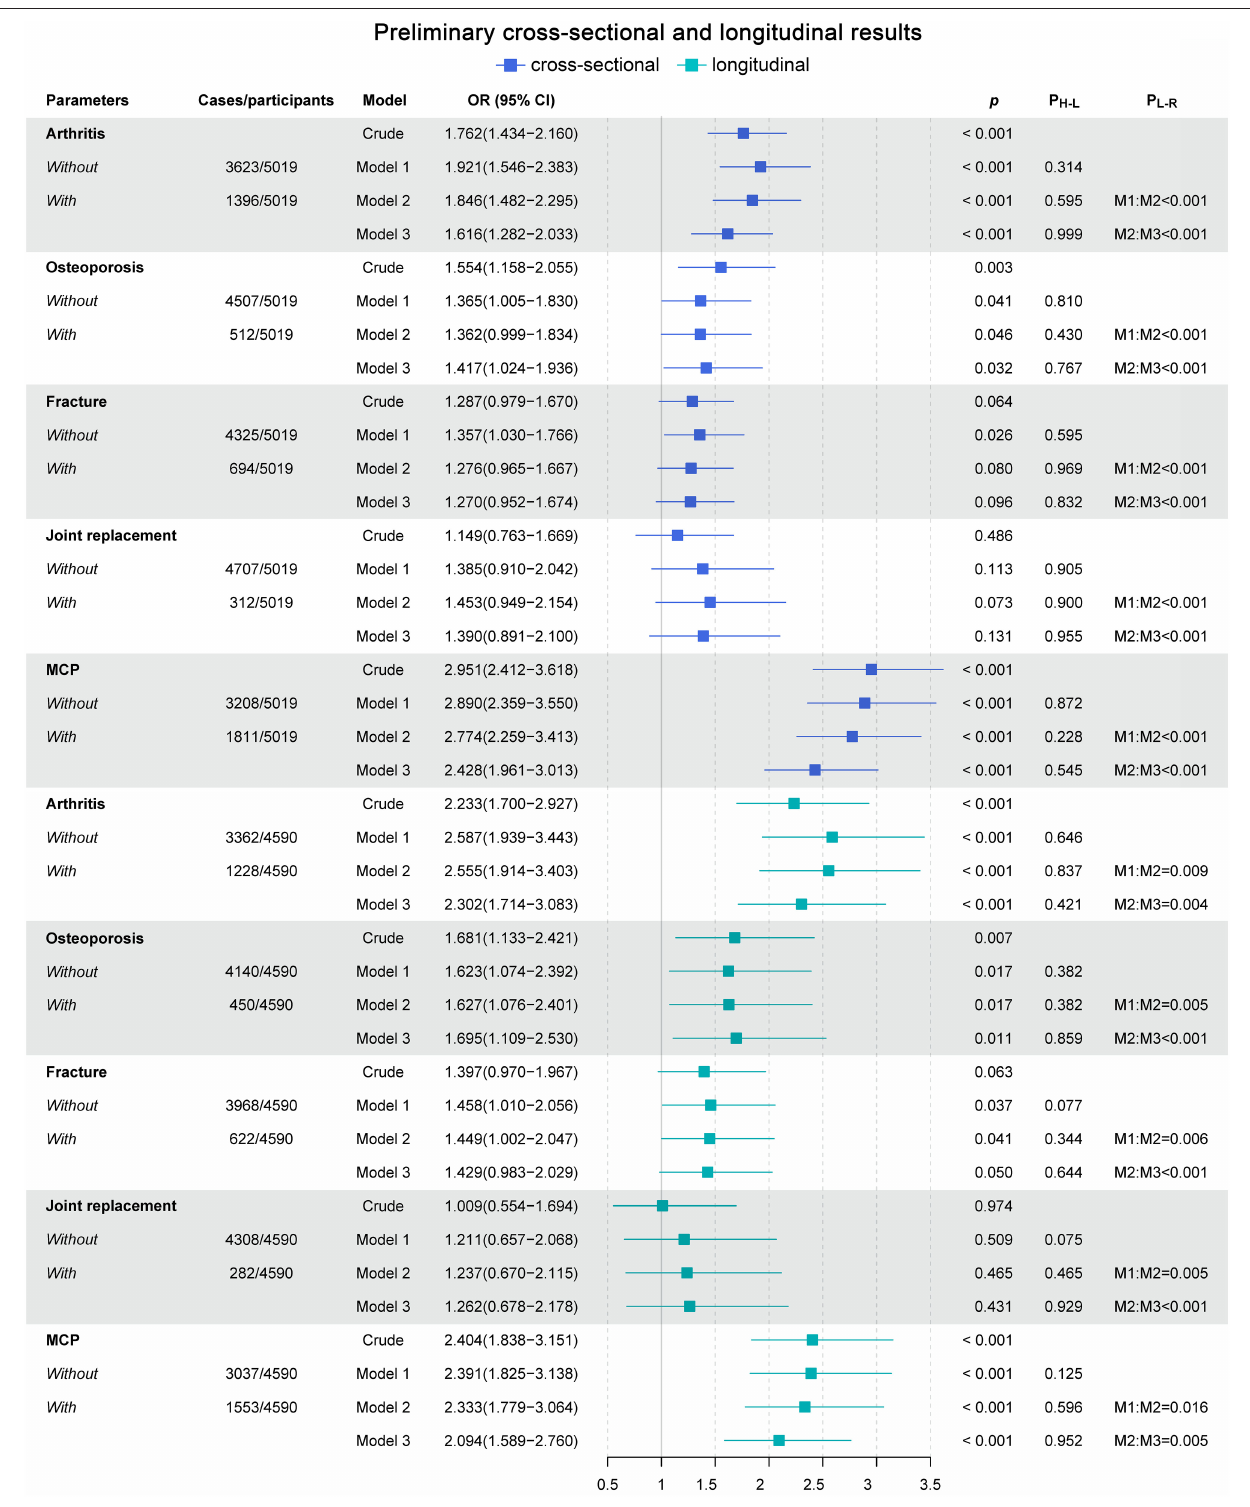
FIGURE 1 | Preliminary cross-sectional and longitudinal results. Model 1 adjusted for gender and age. Model 2 adjusted for Model 1 and place of residence, smoking status, and marital status. Model 3 adjusted for Model 2 and an abnormal heart rhythm, congestive heart failure, angina, myocardial infarction, BMI, diabetes, TRIG, LDL, HDL, CHOL, cognitive score, use of medication [i.e., benzodiazepines, antihypertensives (ATC C09, C08, C07, C03, C02), and anticholinergics (urological, antidepressant, other)], and alcohol. OR, Odds ratios; CI, confidence intervals; p , p -value of binomial logistic regression result; P H − L , p -value of Hosmer–Lemeshow test of goodness of fit; P L − R , p -value of likelihood ratio test; M1:M2, likelihood ratio test conducted between model 1 and model 2; M2:M3, likelihood ratio test conducted between model 2 and model 3. Frontiers in Medicine |